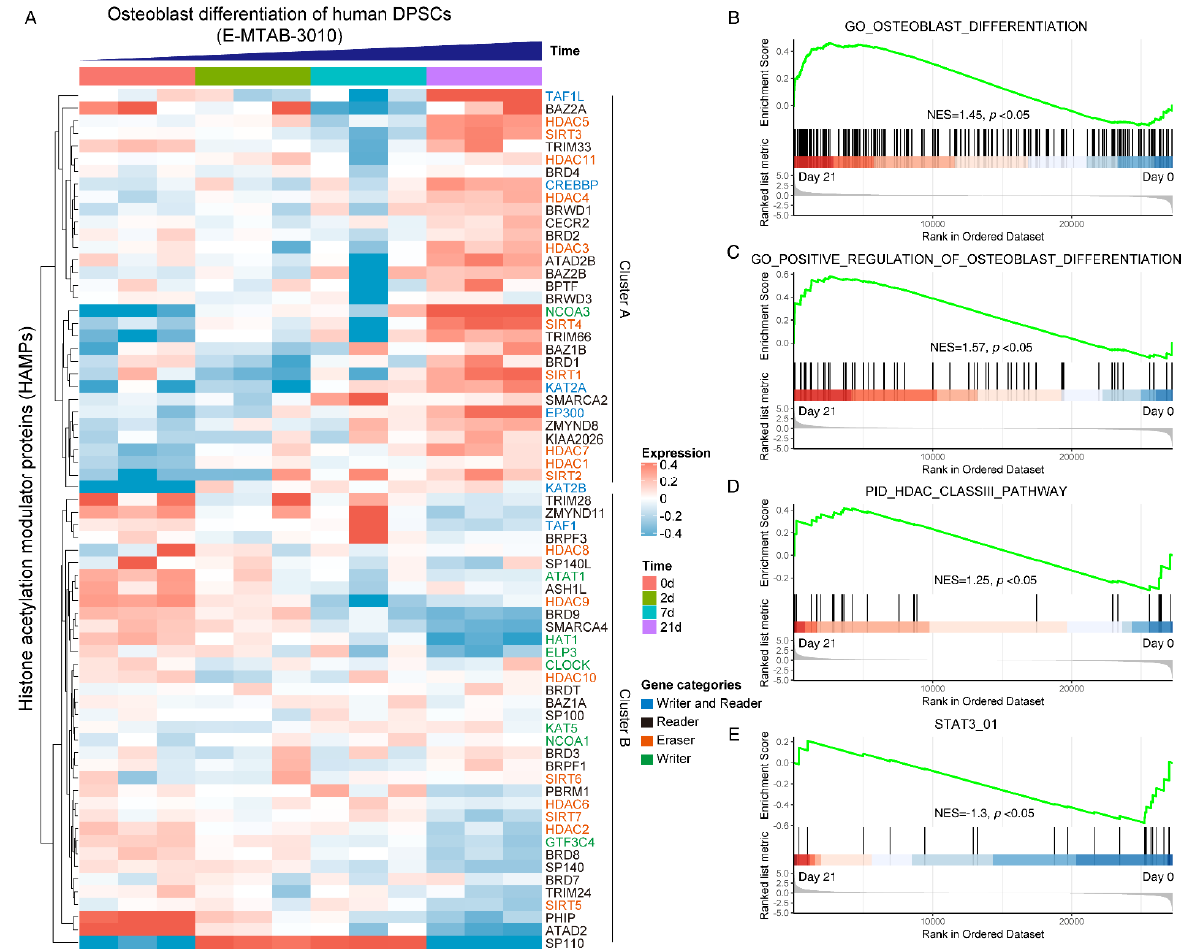
Figure 1. Systematically analyzing the expression pattern of histone acetylation modulator proteins (HAMPs) during osteoblast differentiation of hDPSCs. ( A ) Heatmap showing the expression pattern of HAMPs during osteoblast differentiation of hDPSCs. The gene categories of HAMPs are indicated by different colors. The publicly available dataset was under ArrayExpress accession E-MTAB-3010. Red indicates high expression, and blue indicates low expression. ( B – E ) GSEA analysis of osteoblast differentiation pathway, HDAC class III pathway, and STAT3 pathway on day 0 and day 21. The null hypothesis was “H0: the genes are randomly distributed”.